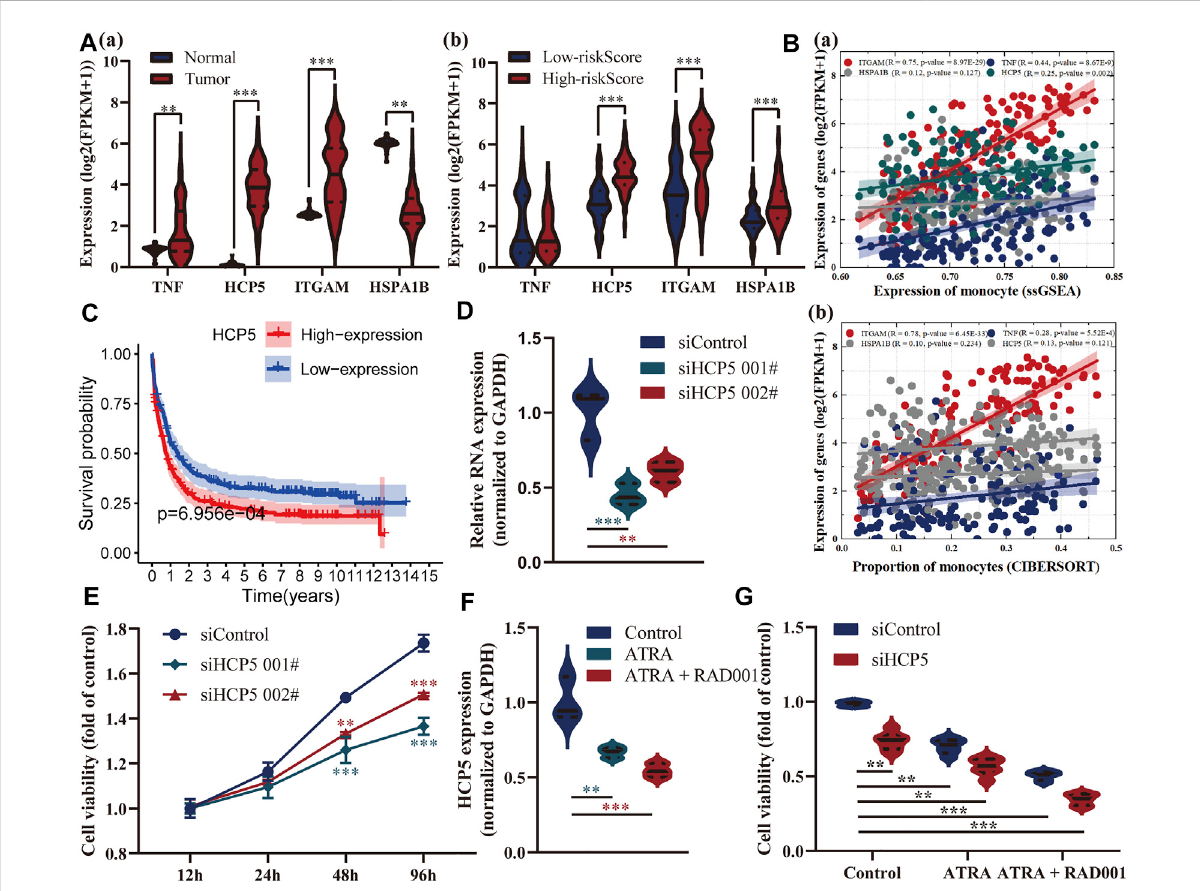
FIGURE 6 Exploration of the relationship between these genes in the model and AML. (A) Analysis of differential expressions of these four genes between AML and healthy patients (a) , high-, and low-risk groups (b) , respectively. (B) Assessment of their correlation with monocytes. (C) Survival analysis of HCP5 in the GSE37642 dataset showed that its expression was associated with prognosis. (D,E) CCK8 results showed that silencing of HCP5 signi fi cantly affected the proliferation of KG-1 cells. (F,G) ATRA (1 μ M) in combination with RAD001 (10 nM) strikingly downregulated the expression of HCP5 and inhibited cell growth, especially in HCP5-silenced